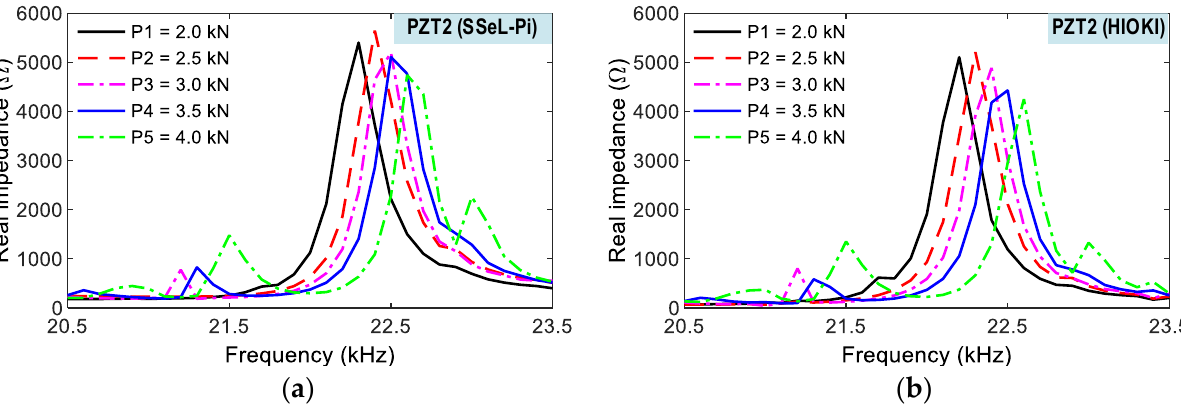
Figure 19. Impedance signals of PZT 1 for compressive loadings P1 – P5. ( a ) SSeL-Pi, ( b ) HIOKI- 3532.